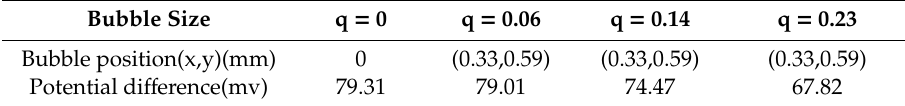
Table 2. The potential di ff erence when the bubble is in the center of the pipe.